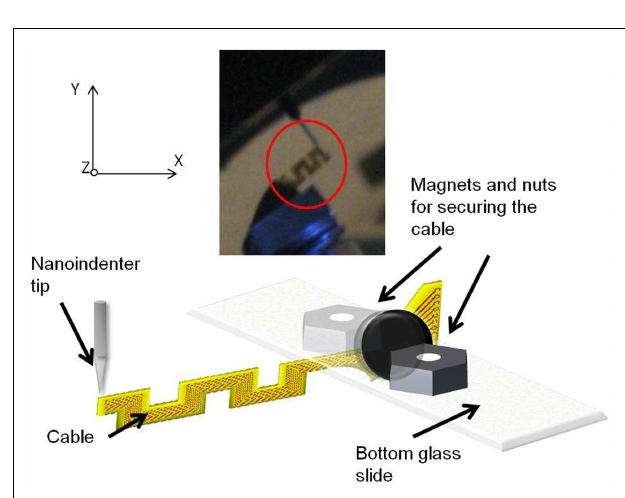
measured using a Hysitron® TriboIndenter (TI 900). The instru-